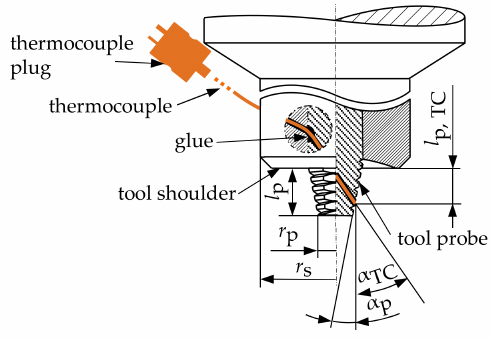
Figure 2. Sketch of the welding tool, data from